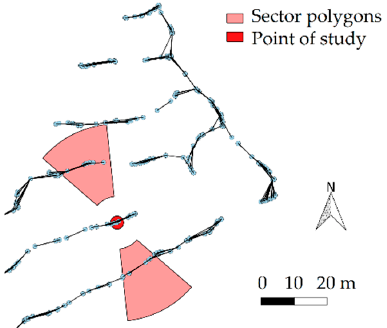
Figure A2. The averaged point data is used to find the directions (shown with black lines) which resemble the strip road network at the stand. The sector polygons are created based on those directions and used to classify the points into stands or external strip roads leading to stands. The ETRS-TM35FIN (EPSG:3067) coordinate system is used in the figure.